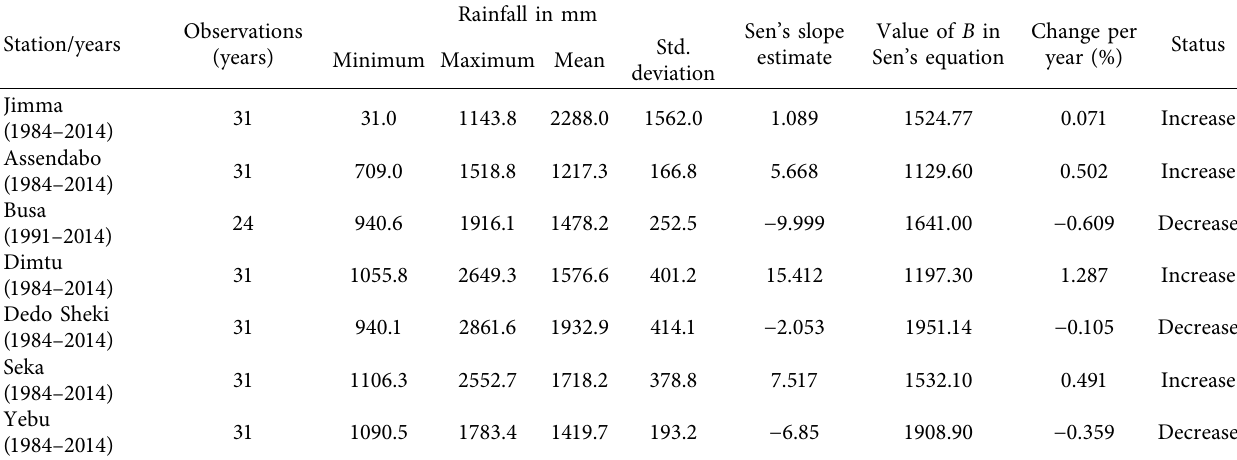
Table 2: Summary of the true slopes of the existing trend for rainfall